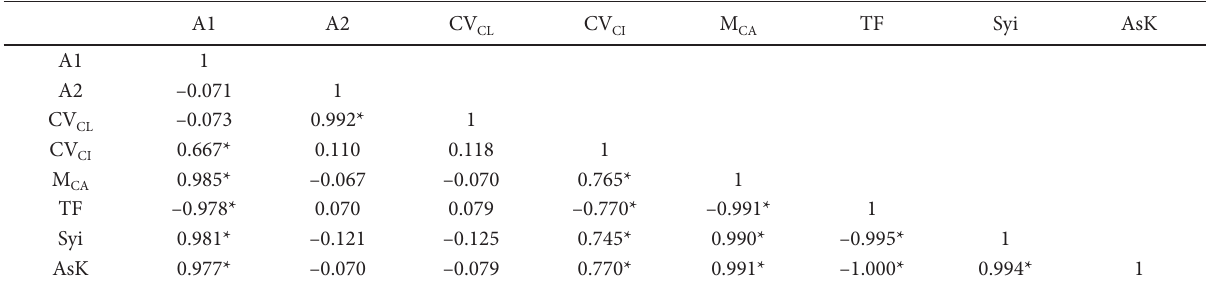
Table 2. Values of Pearson correlation analysis for intra- and inter-chromosomal asymmetry